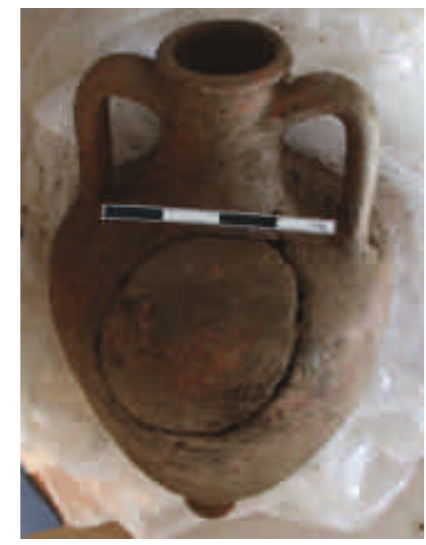
Figure 8 A trade amphora from the Kylindra infant cemetery with a lid cut out of its side to enable a baby to be placed inside